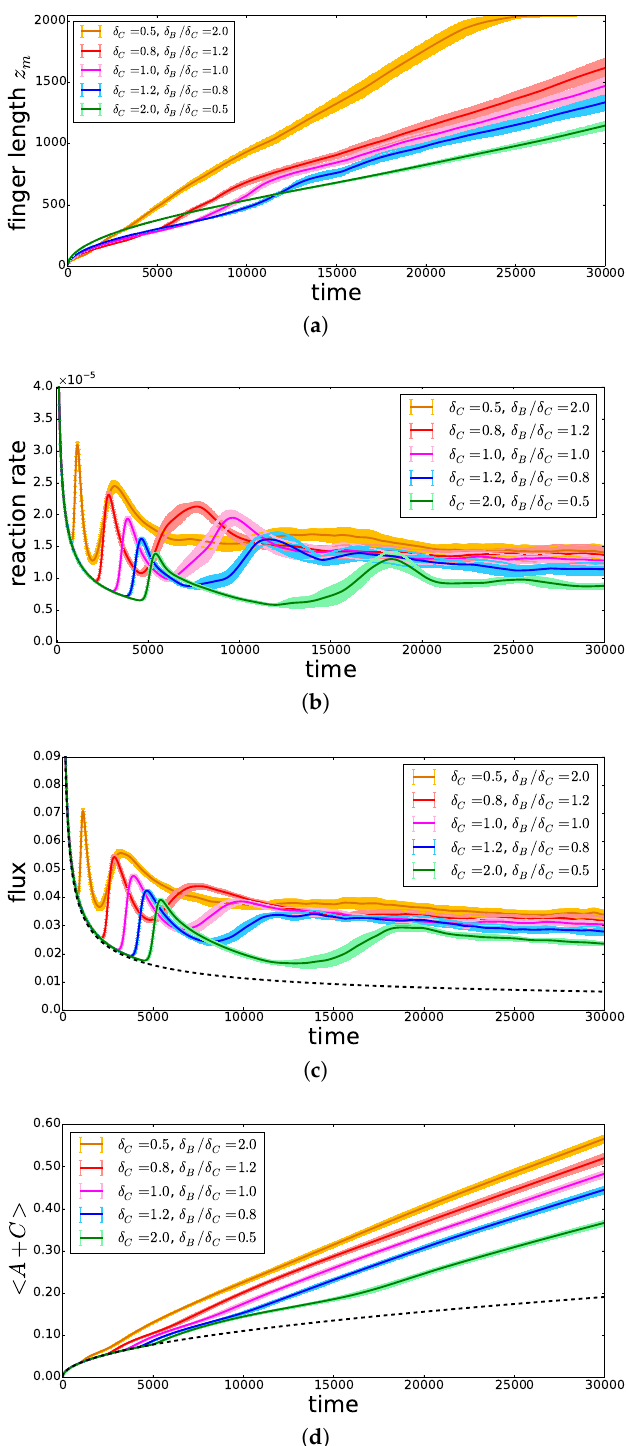
Figure 8. Temporal evolution, for R A = R B = R C = 1, β = 1, δ B = 1 and different δ C , of ( a ) the mixing length z m , ( b ) the average reaction rate < AB > , ( c ) the incoming flux of A and ( d ) the volume-averaged quantity (cid:104) A + C (cid:105) , representing the total amount of A stored in the host solution. The lighter area around each curve represents the 95% confidence interval. The dashed black curves represent the solutions in the non-reactive corresponding